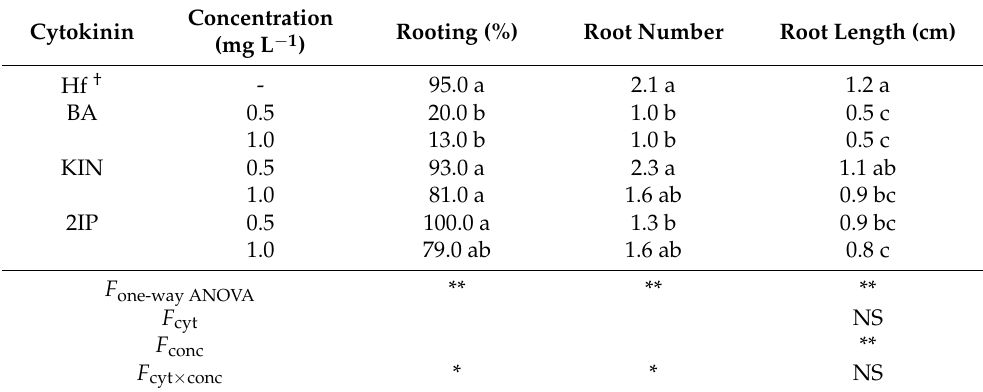
Table 5. In vitro rooting of shoots during first subculture on MS supplemented BA, KIN or 2IP at 0.5 or 1.0 mg L − 1 , or Hf.